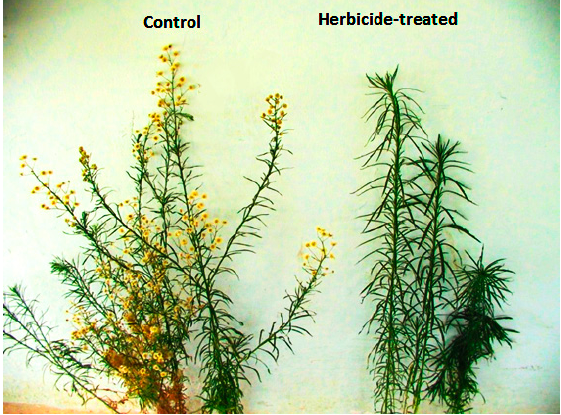
Figure 5. Control and recommended rate Paraquat-treated Conyza bonariensis plants from a population found in Jordan valley (Tal-al-Ramel population, P1).